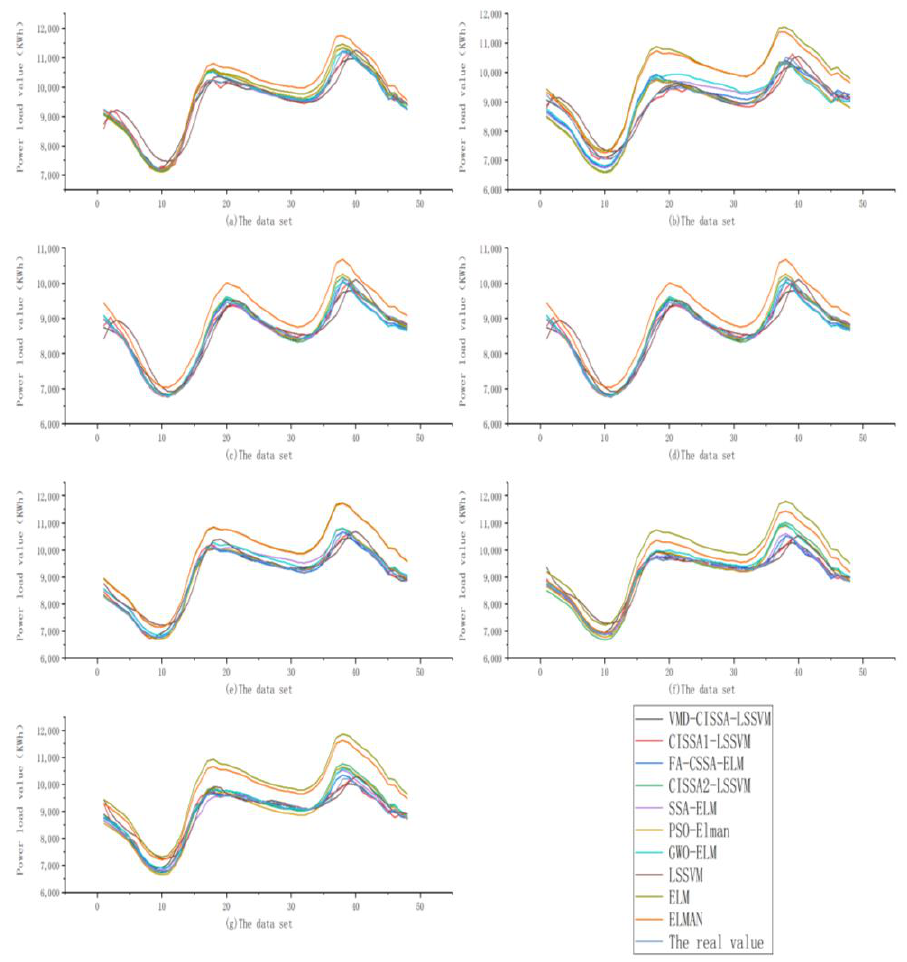
Figure 10. Final daily power load forecast value of different forecast models. ( a ) Prediction results of different prediction models in the Monday subset; ( b ) prediction results of different prediction models in the Tuesday subset; ( c ) prediction results of different prediction models in the Wednesday subset; ( d ) prediction results of different prediction models in the Thursday subset; ( e ) prediction results of different prediction models in the Friday subset; ( f ) prediction results of different prediction models in the Saturday subset; ( g ) prediction results of different prediction models in the Sunday subset.